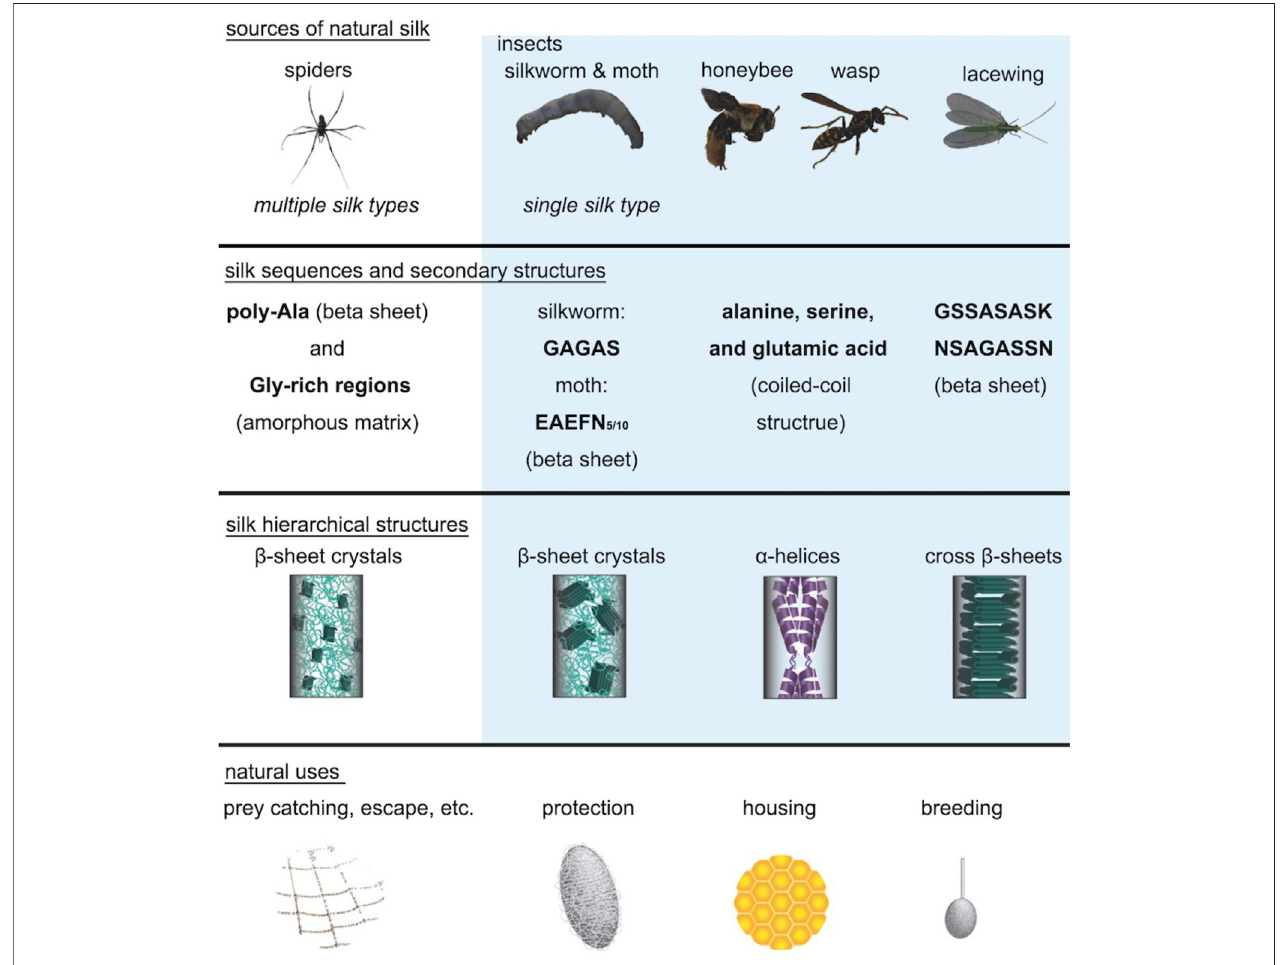
FIGURE2| Naturalsilksderivedfromdifferentanimalspecies.Thesilkstructuresofspiders,silkworms,moths,honeybees,wasps,andlacewingsshowsigni fi cant differences between each other. Spiders, silkworms, and moths all have silks in which β -sheet crystals are embedded in the amorphous matrix. However, the β -sheet crystalsinspidersilkaremuchsmallerthanthe β -sheetcrystalsinsilkwormsilkandarehighlyalignedalongthe fi beraxis.Honeybeesilkandwaspsilkmainlyconsistof α - helix structures, while lacewing silk consists of cross β -sheet structures. These silk secondary structures are highly related to their properties and functions. Adapted with permission from ref (Aigner et al., 2018). Copyright 2018 WILEY-VCH.